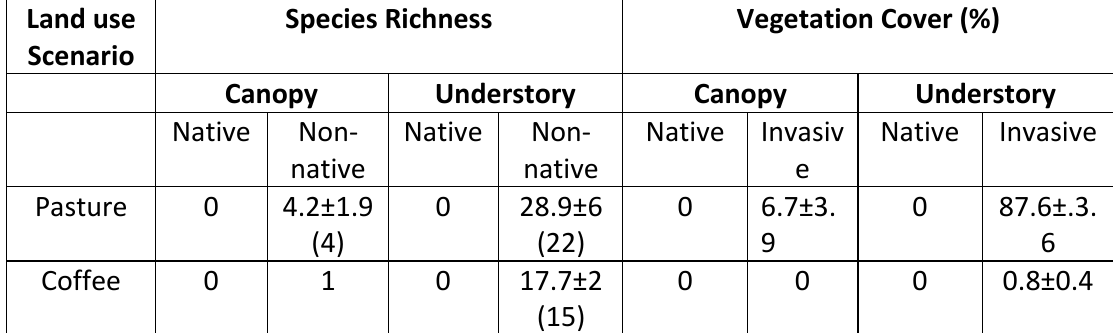
Table A1.13. Species richness and vegetation cover by land-use scenario in Kaʻūpūlehu Hawaiʻi. Values represent means ± 1 SE. The category “non-native” includes both introduced and invasive species. Species richness was estimated using a Bootstrap estimator, numbers in parentheses represent actual species counts from the